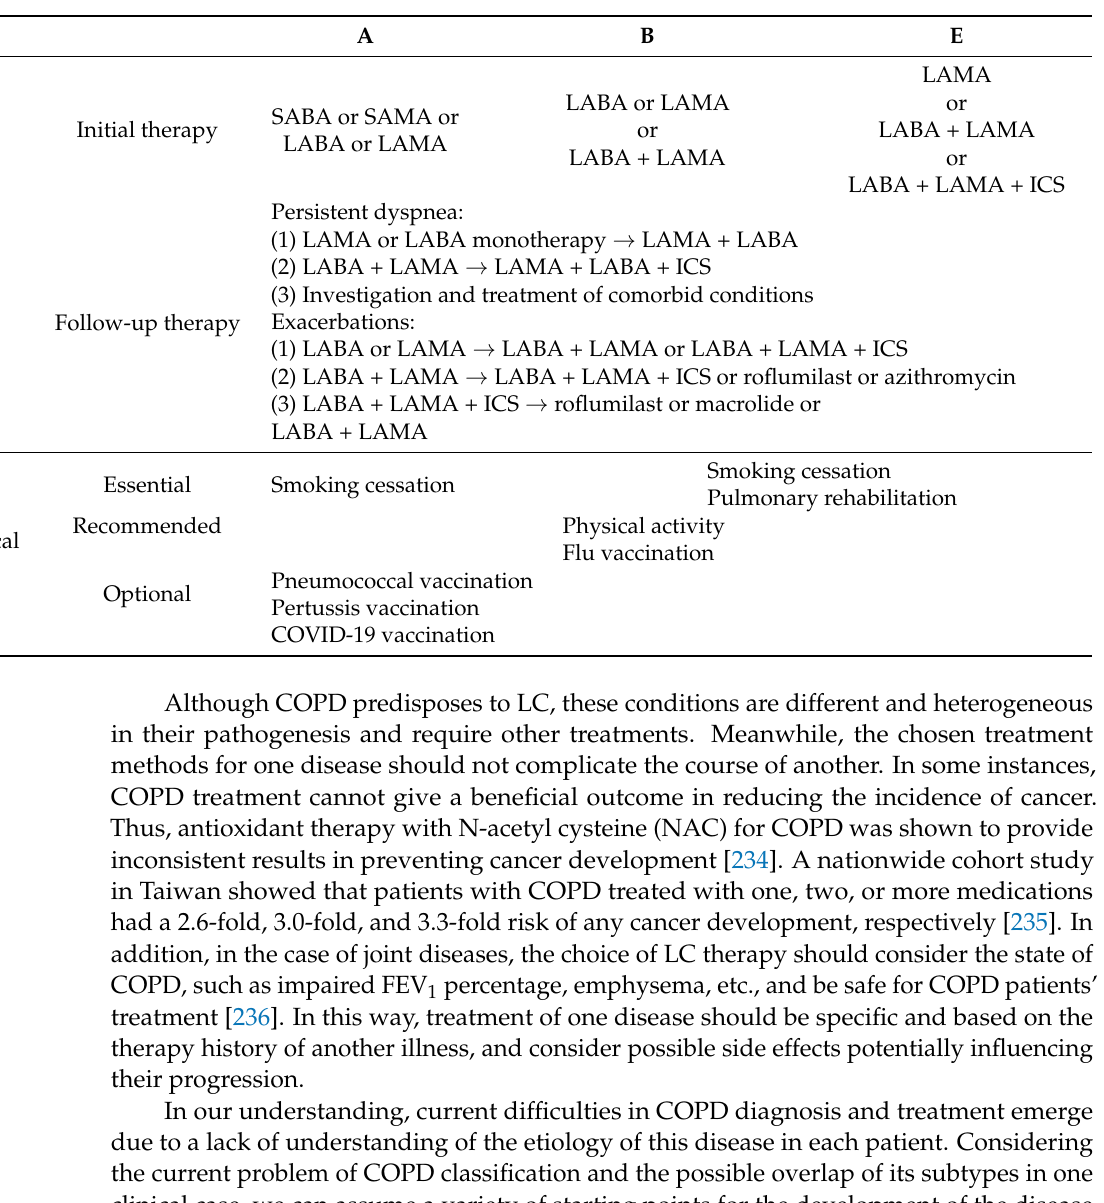
Table 3. GOLD group classification and treatment of COPD. Abbreviations: SABA, short-acting beta- agonists; SAMA, short-acting antimuscarinic; LABA, long-acting beta-agonist; LAMA, long-acting antimuscarinic; ICS, inhaled